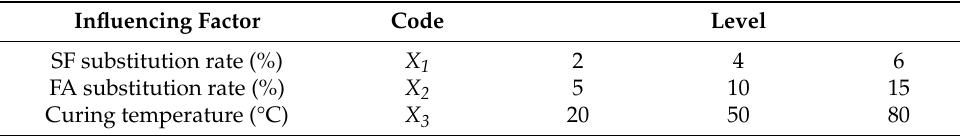
Table 2. Factor codes and levels.